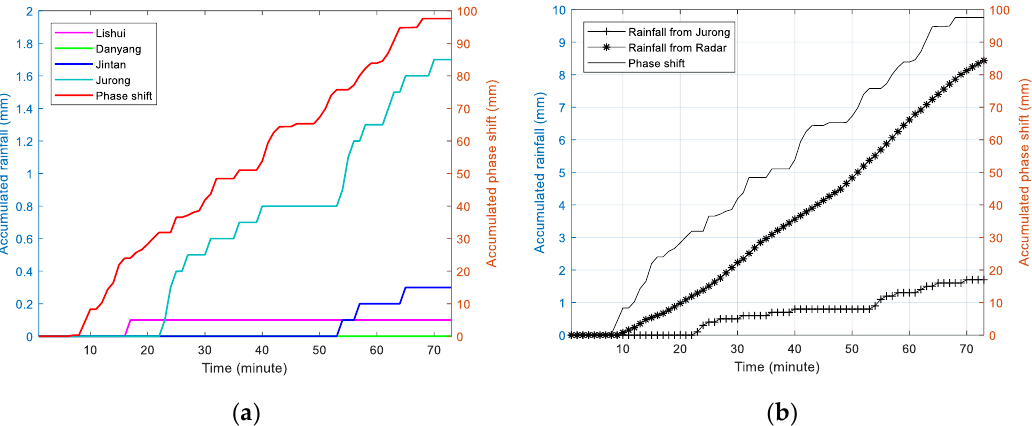
Figure 13. Case of accumulated phase shift on 10 August 2015 compared with accumulated rainfall observed from four weather stations and calculated from radar, respectively: ( a ) comparison results with data from four weather stations; ( b ) comparison results with data from Jurong weather station and radar.